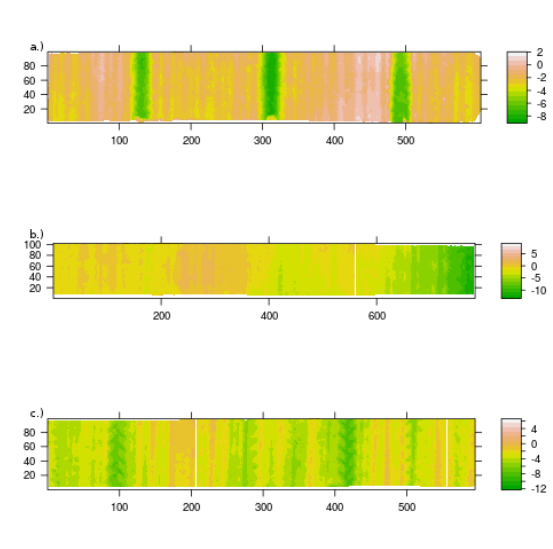
Figure 2: Three sample DSMs of different roughness plots show- ing a.) a significant two scale roughness pattern (R12), b.) a spatial trend (R14) and c.) no spatial trend with an insignificant two scale roughness pattern (R21). Units in cm